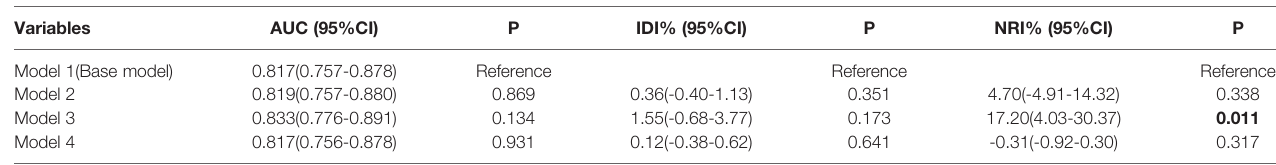
AUC, area under curve; IDI, integrated discrimination improvement; NRI, net re-classi fi cation improvement. Model 1=Tumor size+ Depth of invasion+ Tumor differentiation+ LNM; Model 2=Model 1+ Gender; Model 3=Model 1+ Circumferential extension; Model 4=Model 1+ Multiple lesions. The bold value means statistical signi fi